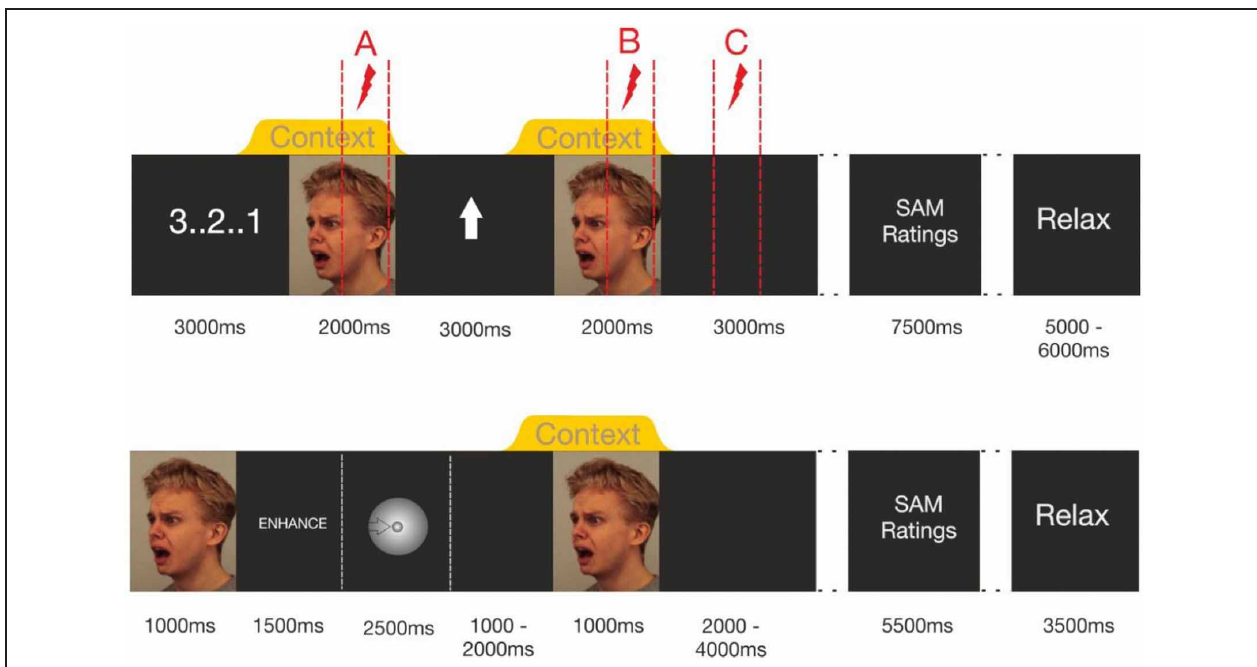
FIGURE 1 | Trial timing in Experiment I (upper half of figure) and Experiment II (lower half). Note that Experiment 1’s dotted lines indicate the intervals in which startle probes were delivered. Within each trial only one of these probes was